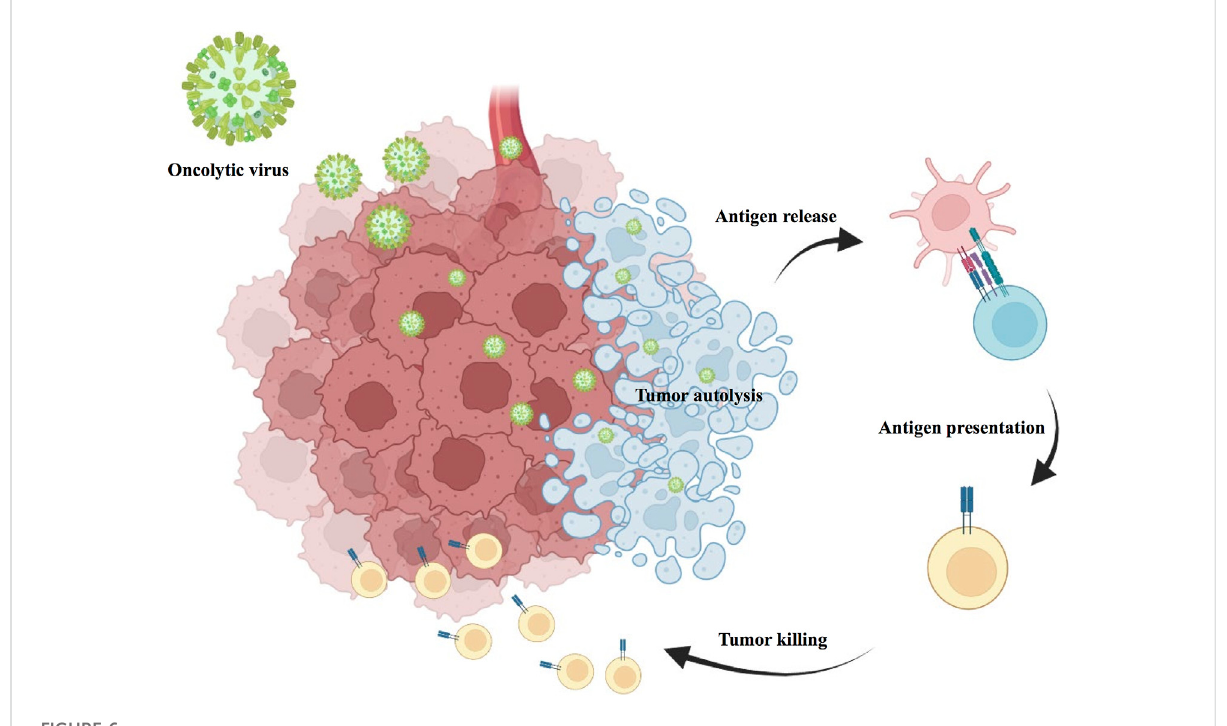
Immunomodulatory mechanisms of oncolytic viral